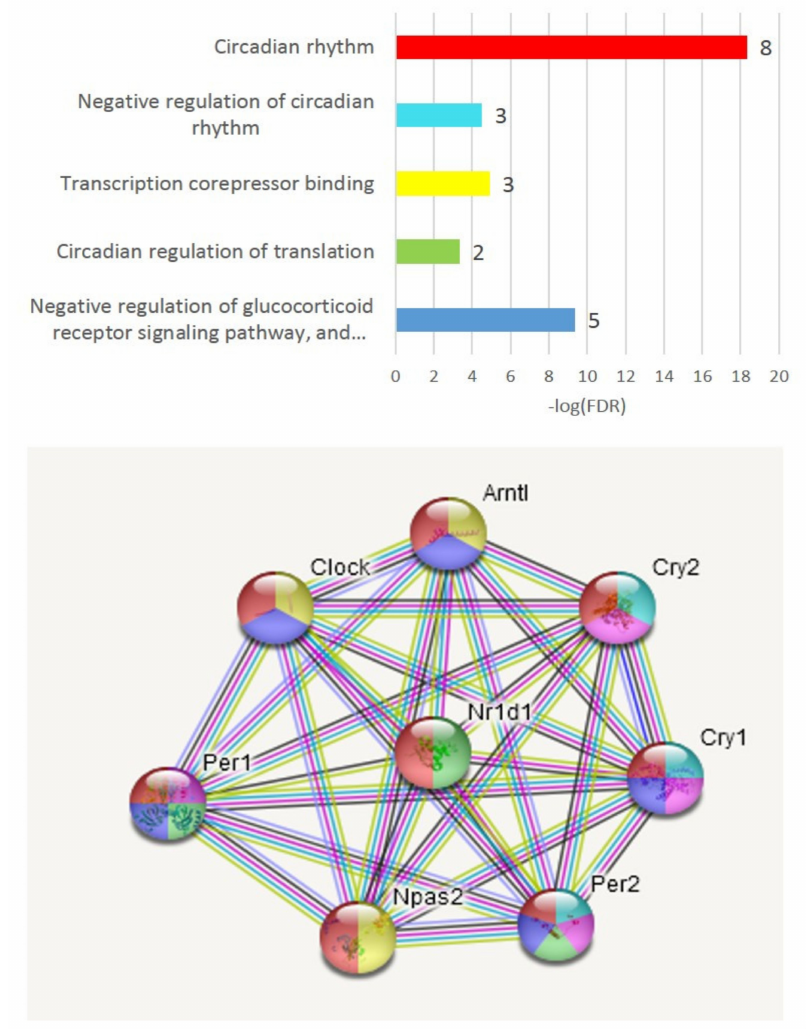
Figure 5. Eight circadian rhythm genes subset expanded from Arntl DEG and annotated by string-db suite (Figure